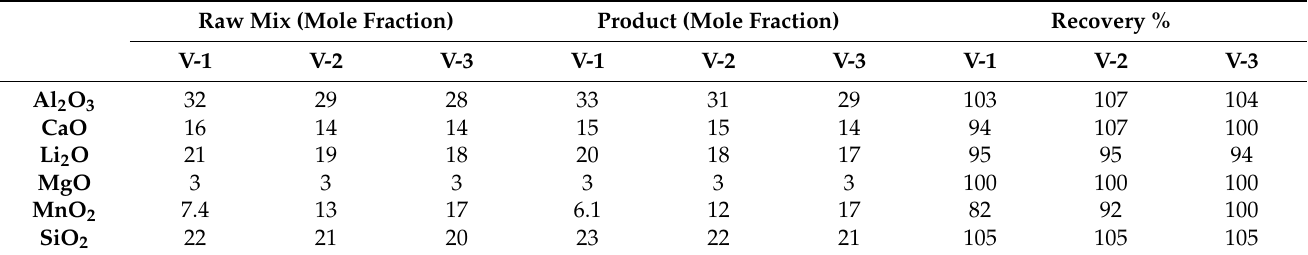
Table 2. Comparison of the bulk chemical composition of the three melt experiments, given in mole percent. Raw Mix (Mole